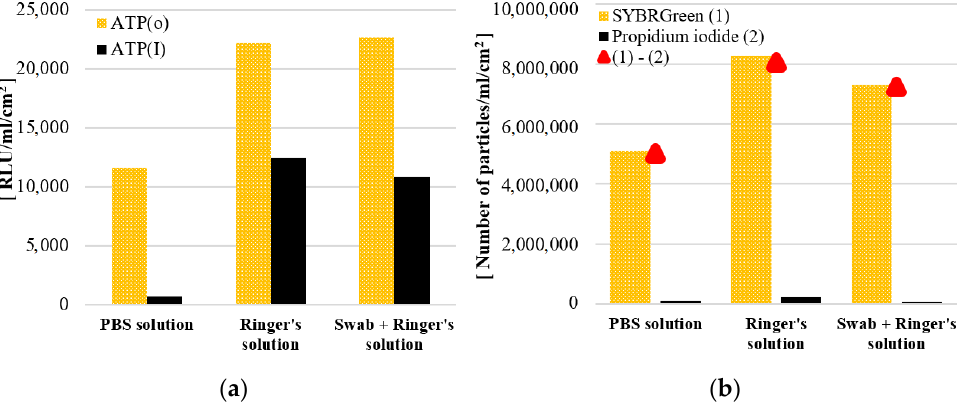
Figure 3. Average ATP value ( a ) and average number of microorganisms measurement by flow cytometry ( b ) using different methods of biofilm detachment.